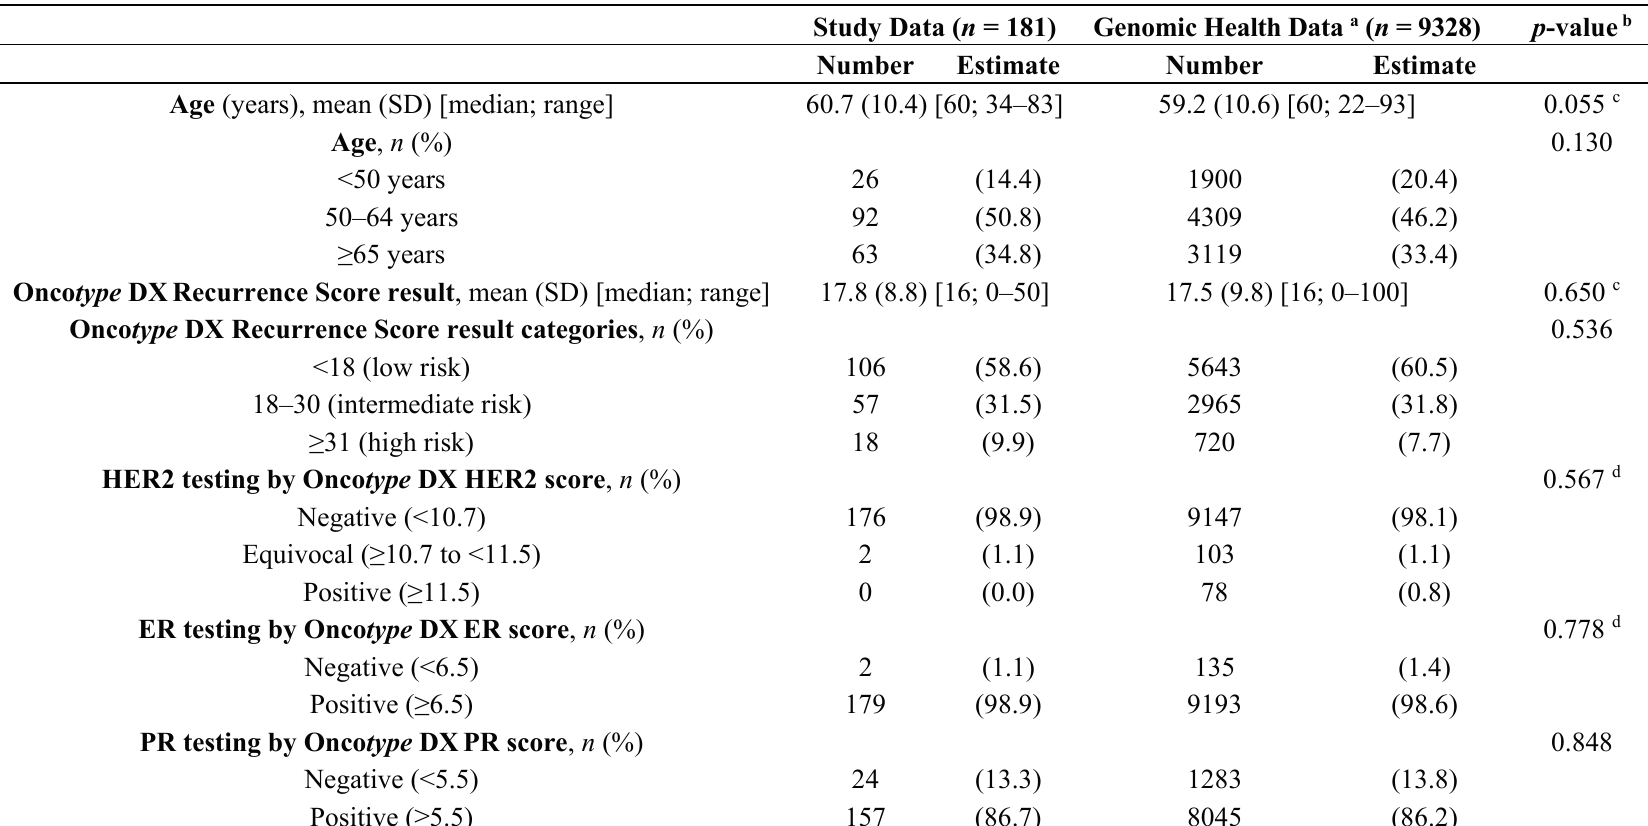
Table 4. Comparison of study characteristics with Genomic Health data of pN1mi patients in a comparable time